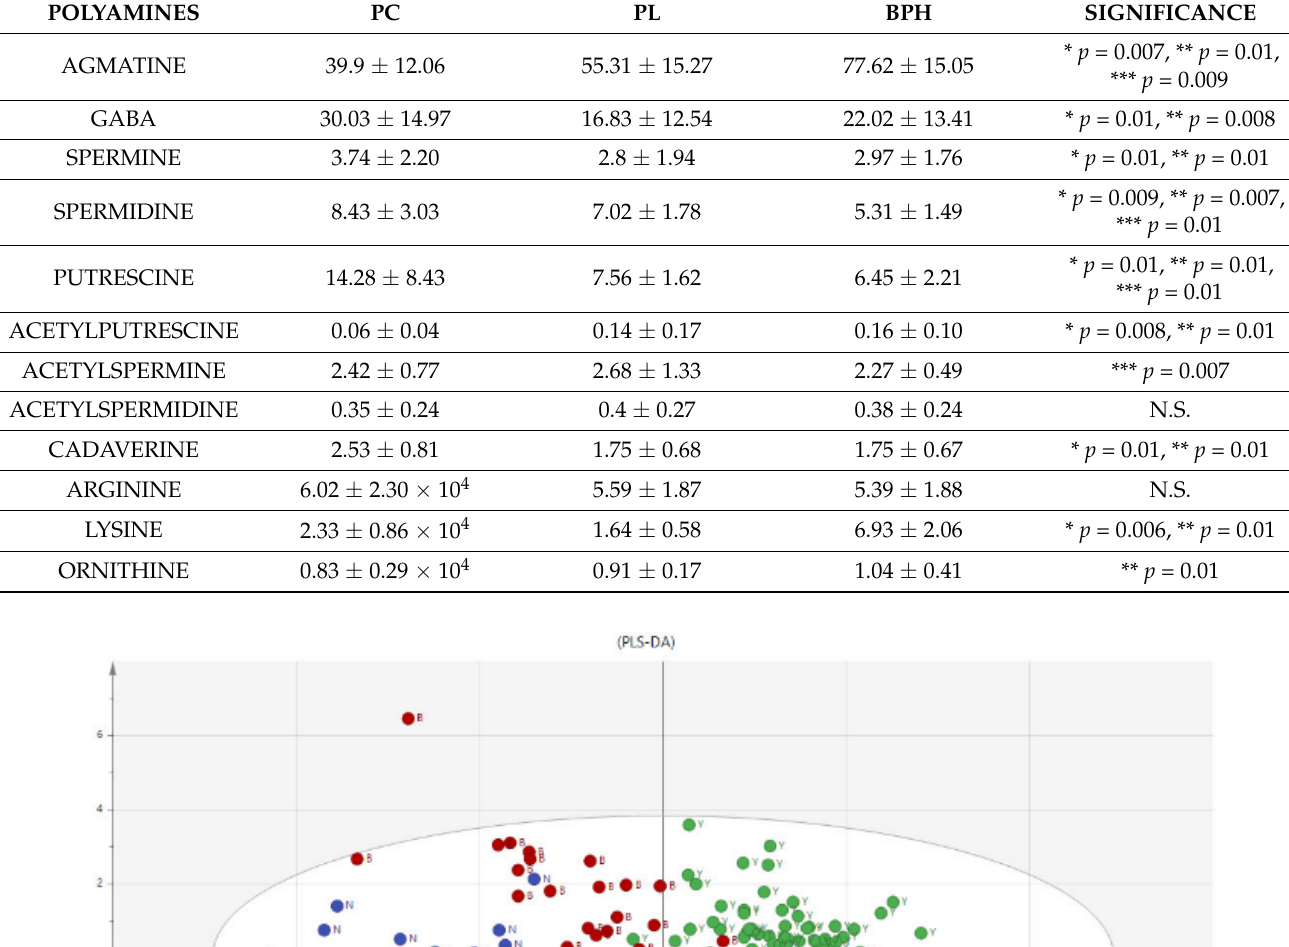
Table 2. Level of plasma polyamines, plasma correlated amino acids (arginine, lysine) and metabo-